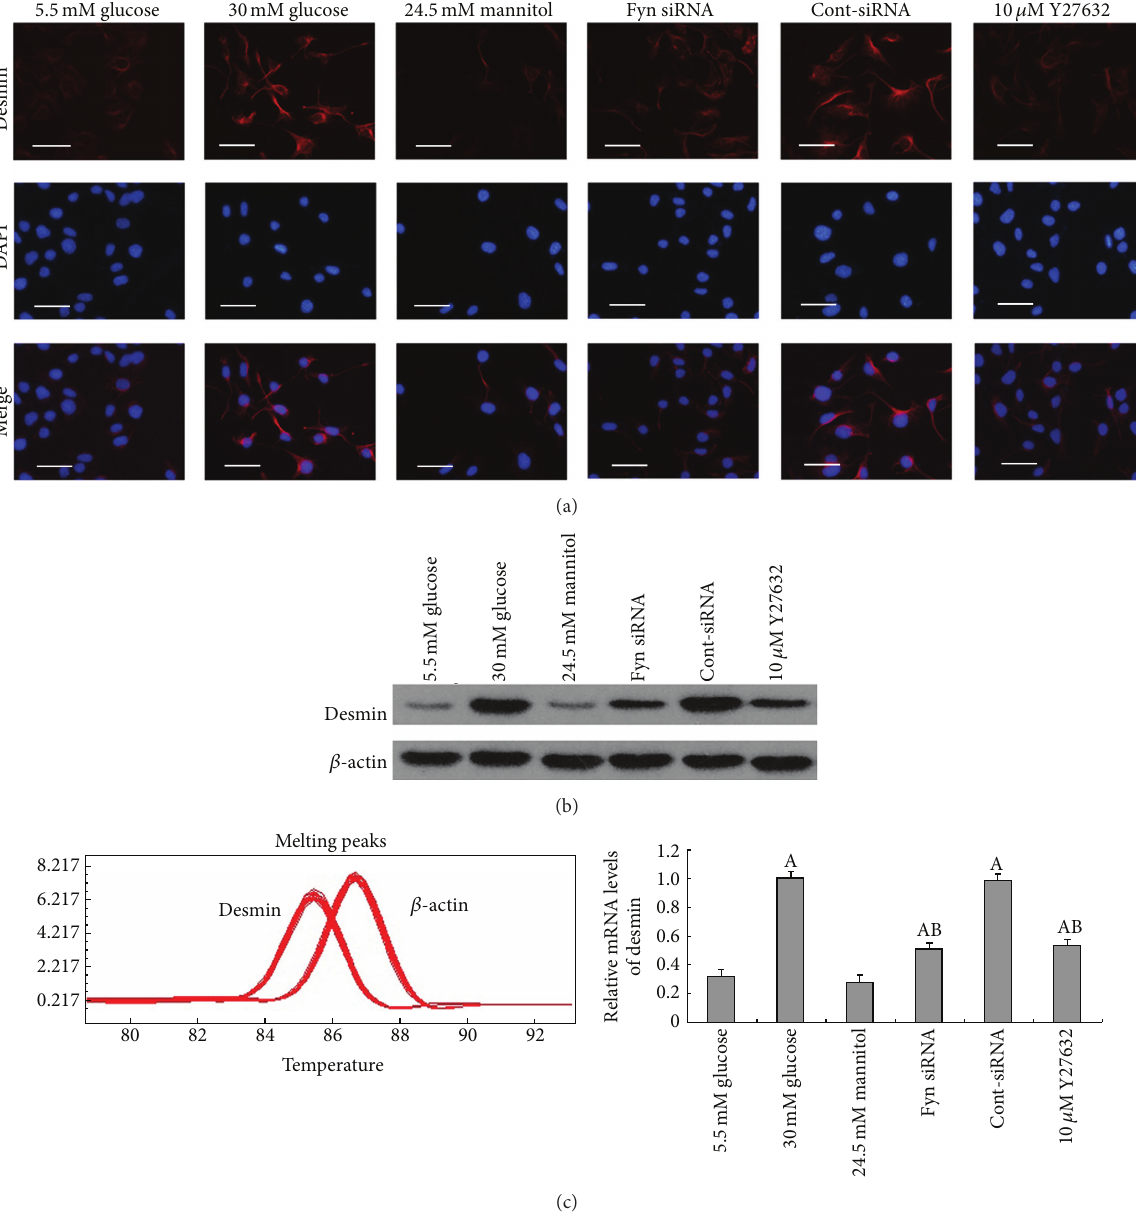
Figure 3: Changes of desmin on protein and mRNA levels in podocytes under different stimulations. Immunofluorescence (a), western blot (b), and real-time PCR (c) presented that desmin protein was increased markedly following incubation with 30 mM glucose for 48 hours (column 2), and the increase was partially inhibited by transfection with Fyn siRNA for 24 hours (column 4) or pretreatment with 10 𝜇 M Y27632 for 30 minutes (column 6). Control podocytes were treated with Cont-siRNA (column 5) or 5.5 mM glucose plus 24.5 mM mannitol (column 3). Magnification: 400x. Values denote the mean ± SD; A 𝑃 < 0.05 versus 5.5 mM glucose and B 𝑃 < 0.05 versus 30 mM